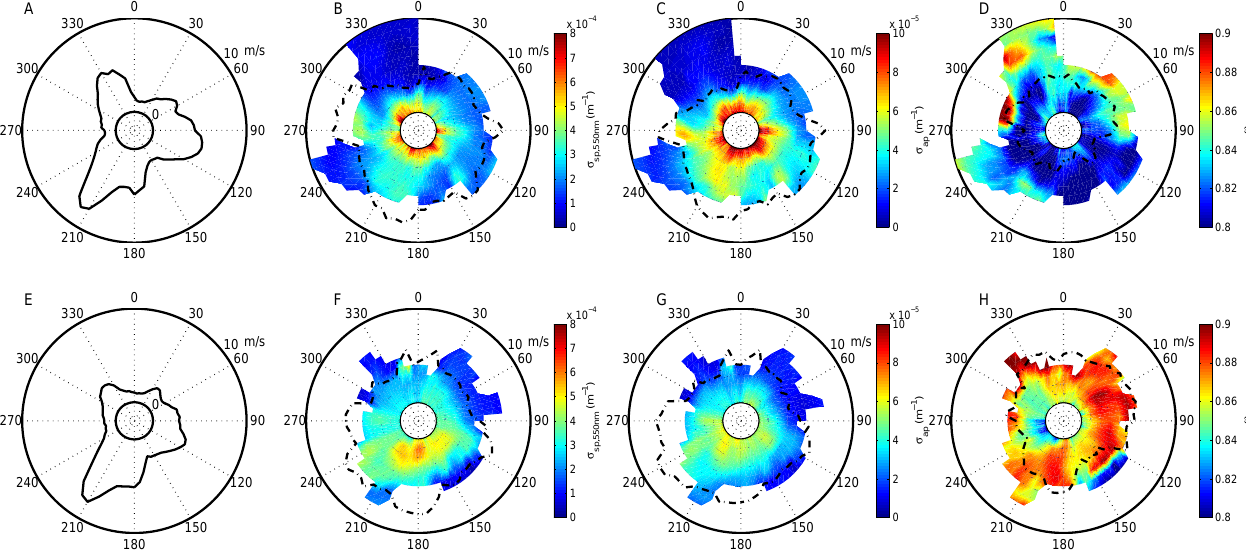
Fig. 3. Wind speed and direction dependence map of σ sp (B, F) , σ ap (C, G) and ω (D, H) , as well as wind rose (A, E) . The upper fours pictures are for spring and the lower ones are for summer. In each picture, the shaded contour indicates the average of variables for varying wind speeds (radial direction) and wind directions (transverse direction). The dash-dot lines stand for the relative mean values at each wind